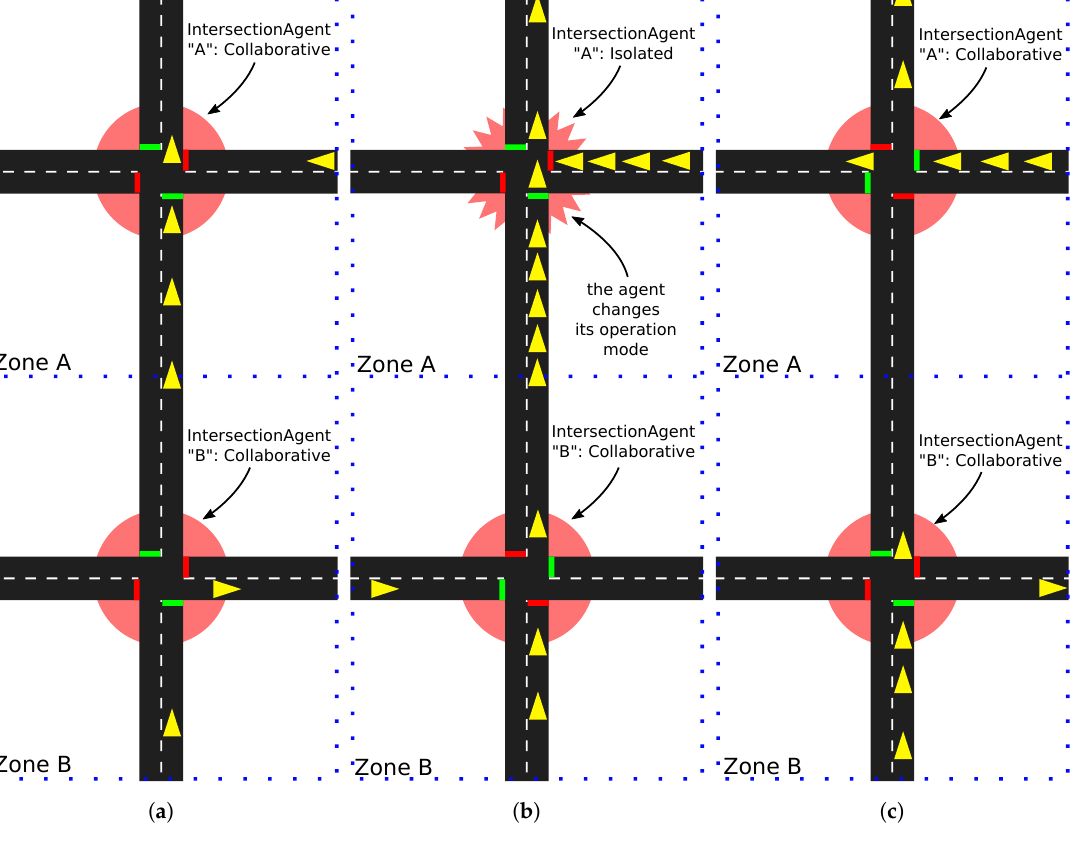
Figure 3. Multi-Agent System operation use case. ( a ) initial state; ( b ) zone “A” congested; ( c ) zone “A” normal